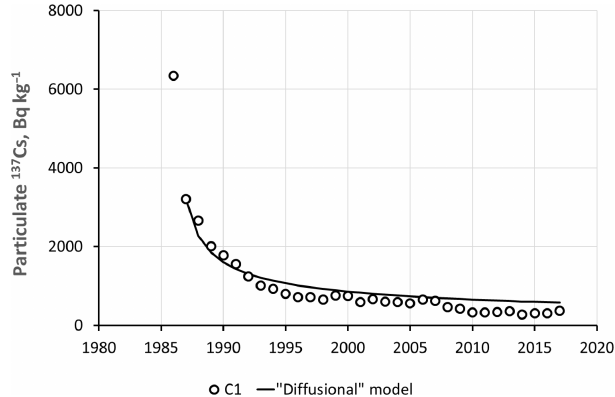
Figure 4. Diffusion based semi-empirical modelling of recon- structed particulate 137 Cs in the Upa River (line) based on the depth profile for the bottom sediments in core C1 (points).